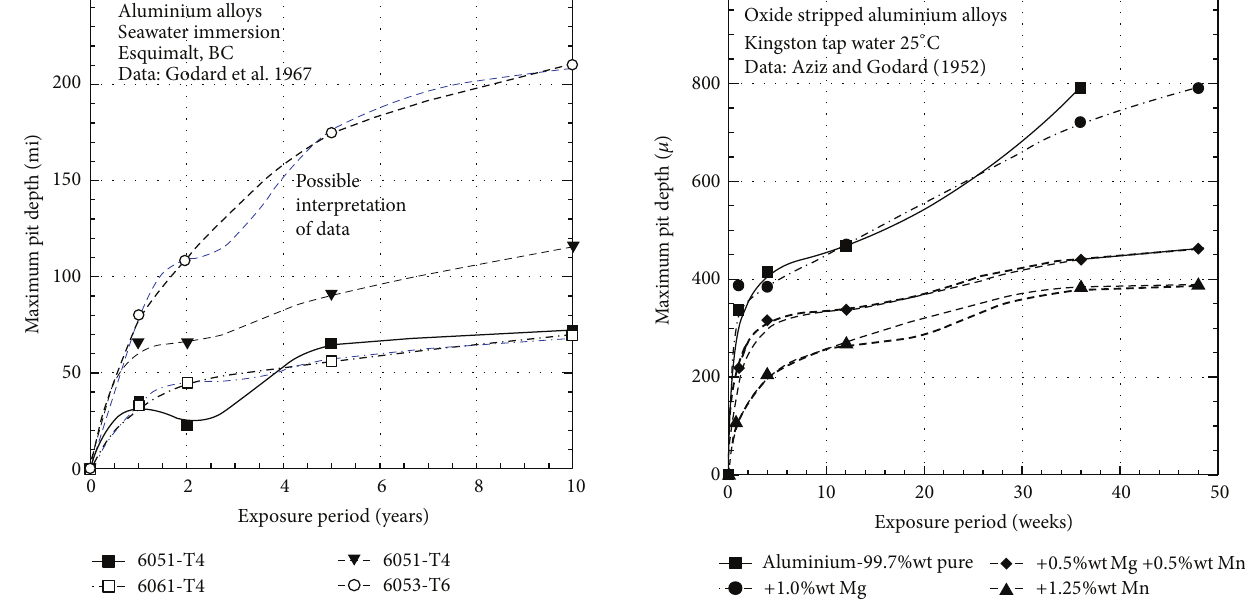
Figure 13: Data and fitted trends for several 6xxx series aluminium alloys exposed to seawater immersion conditions at Esquimalt, BC, Canada. The changeover to mode 2 occurs at around 2-3 years of exposure. Data from Godard et al. [16].